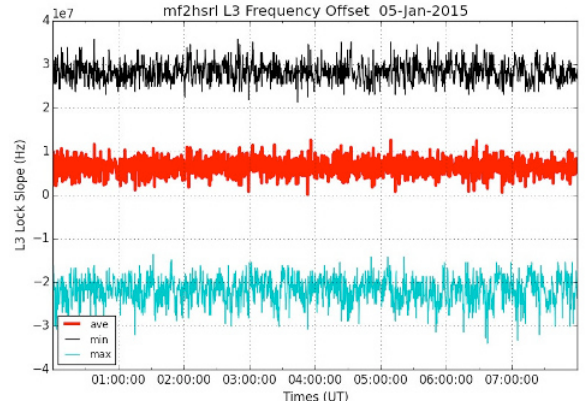
Figure 4: Frequency error over 8 hours with I active. (calibrated I 2